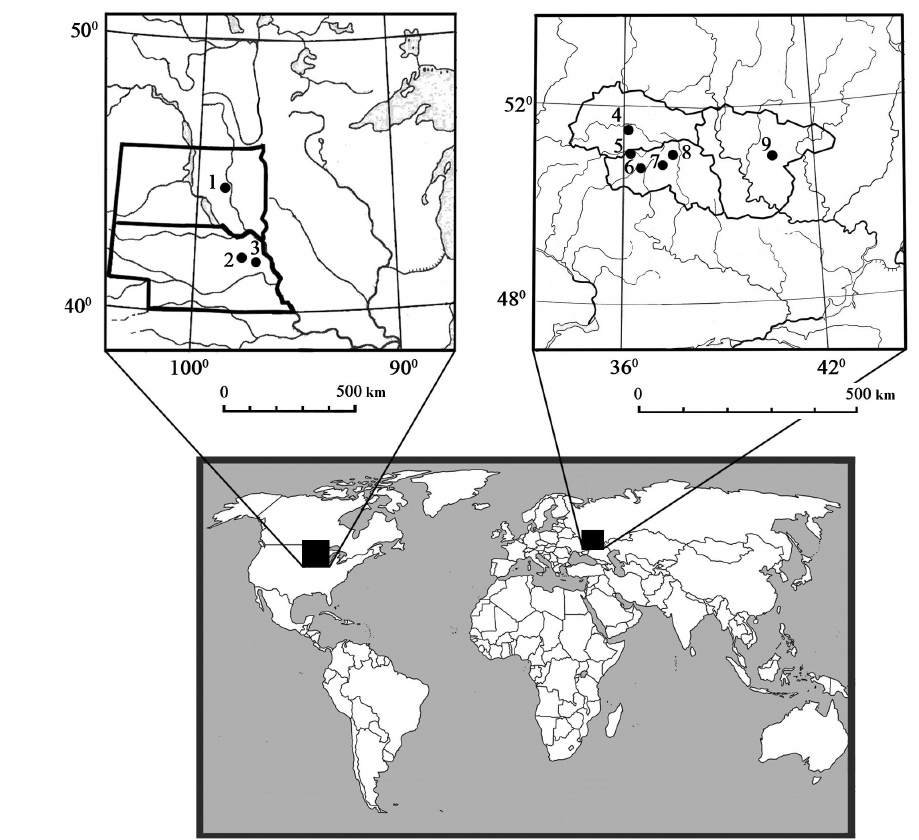
Figure 1. Geographical locations of the nine study sites within the United States ((1) Huron, (2) Norfolk, (3) Mead) and Russia ((4) Streletskaya Steppe, (5) Ivnyanskiy, (6) Prokhorovskiy, (7) Gubkinskiy, (8) Yamskaya Steppe, (9) Kamennaya Steppe). Within Russia, (5), (6), and (7) are sites with chronosequences of land use conversion, while (4), (8), and (9) are paired sites (native grasslands, annual croplands versus shelterbelts). The three sites in the United States are paired sites (afforestation vs. adjacent annual